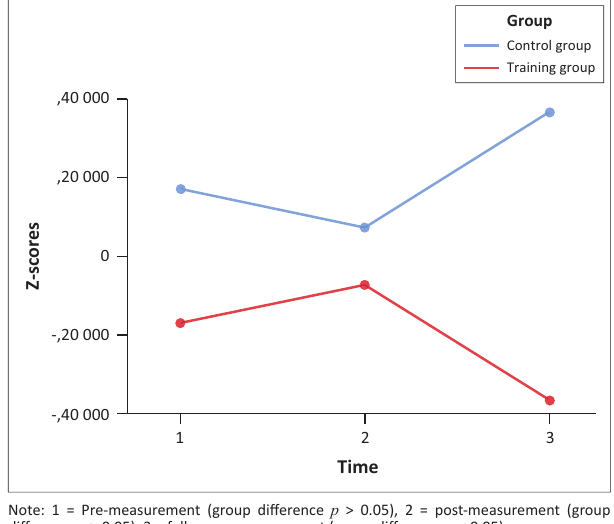
FIGURE 1: Mathematics word problem performance between the training group and control group. (Estimated marginal means of a maths word